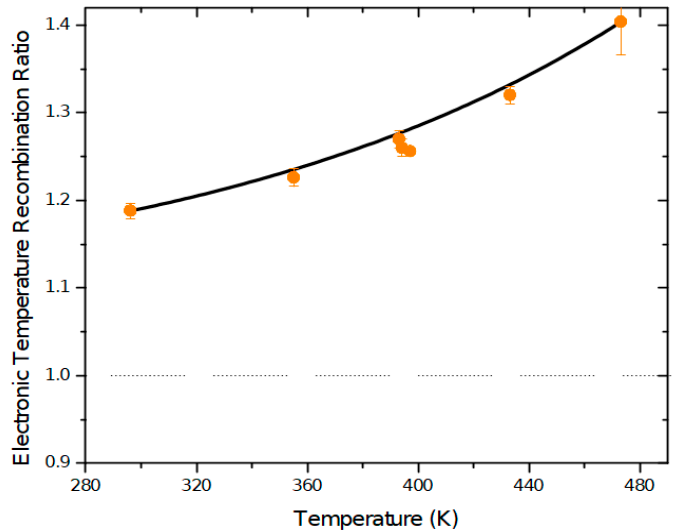
Figure 9. Temperature Ratio at Various Temperatures, and Voltages V > 5* k B T/q showing the ratio of the computed Spectrum Temperature to measured Junction Temperature. Lower voltages drop below this curve. Figure 10 covers only 200–202 °C at various voltages. At voltages above 240 mV, it seems flat. 176 mV may be part of a trend. The ~0 mV results are all over the place. We would expect that for negative values, the temperature ratio would be less than 1. That is because hot electrons would drift across the heterojunction freely, while lower energy electrons would mostly reflect off it. On this basis, there should be a trend.